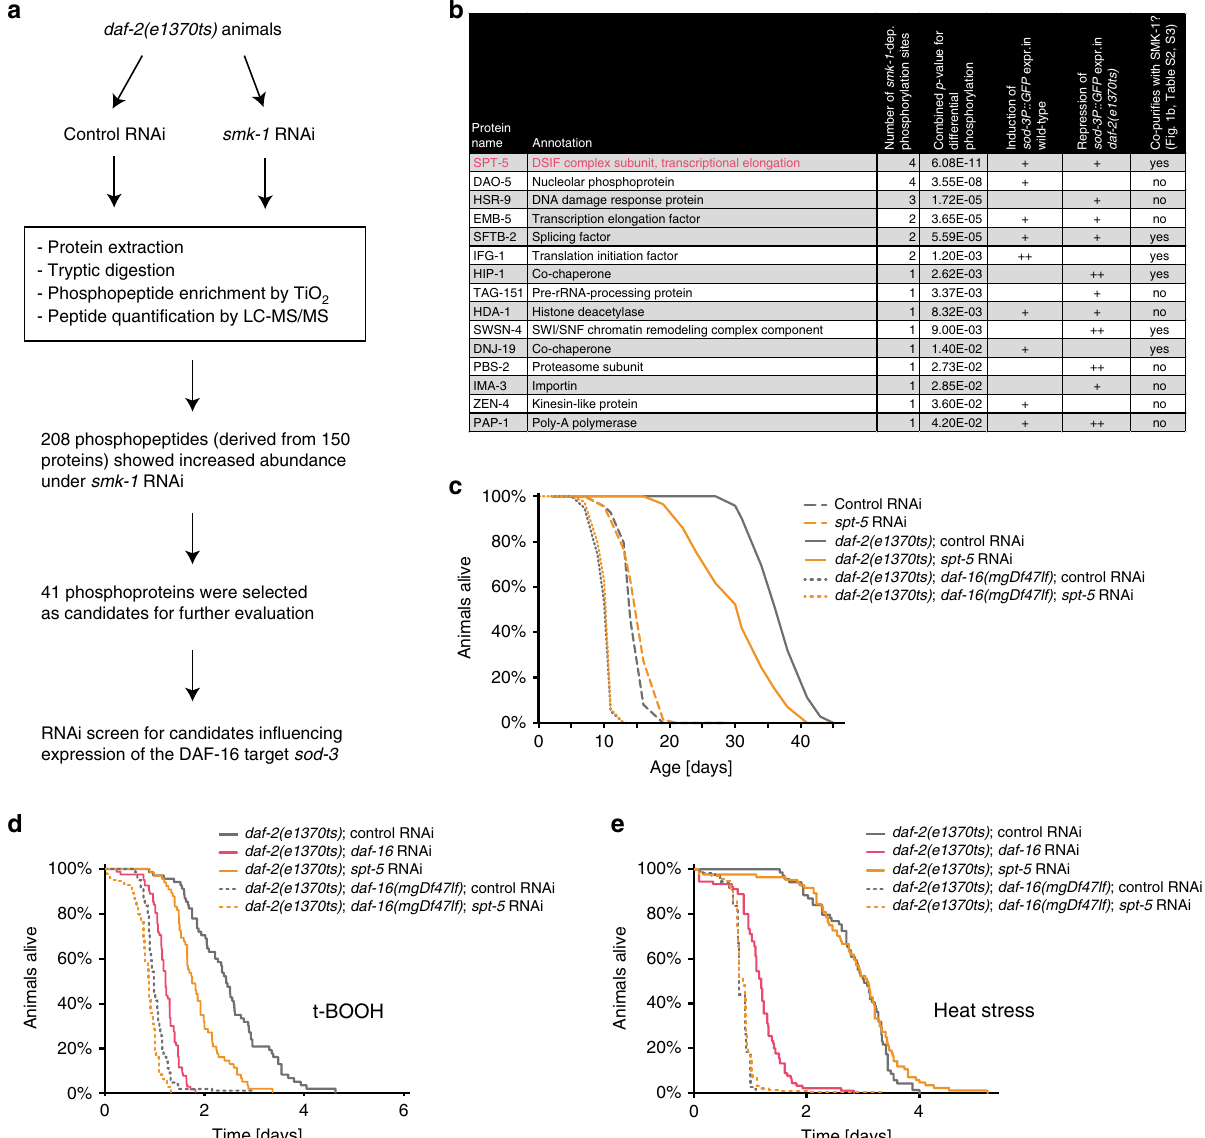
RNAi screen for candidates influencing expression of the DAF-16 target sod-3